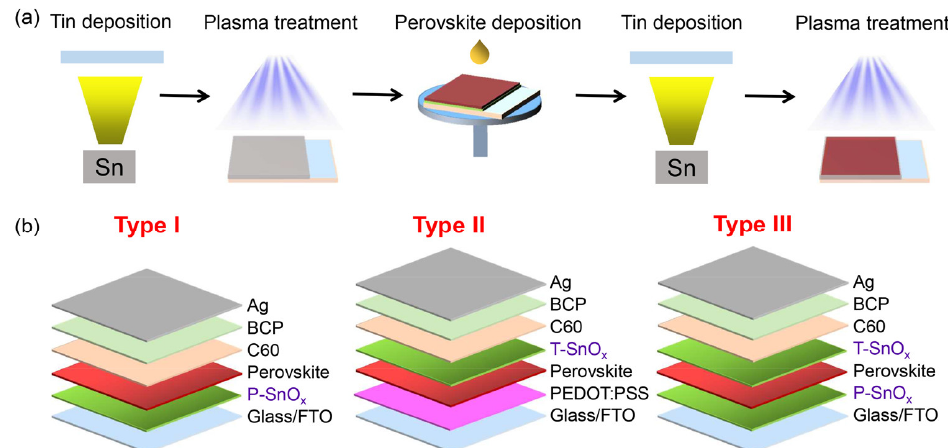
Figure 13. ( a ) The Sn-PVK solar cells fabrication process using plasma-treated tin as a SnOx film working as an ambipolar layer. ( b ) Role of plasma-grown SnOx was studied in three different solar cell structures, either as a HTM or perovskite protective layer or the combination of both. Reproduced with permission [49]. Copyright 2022, American Chemical Society.